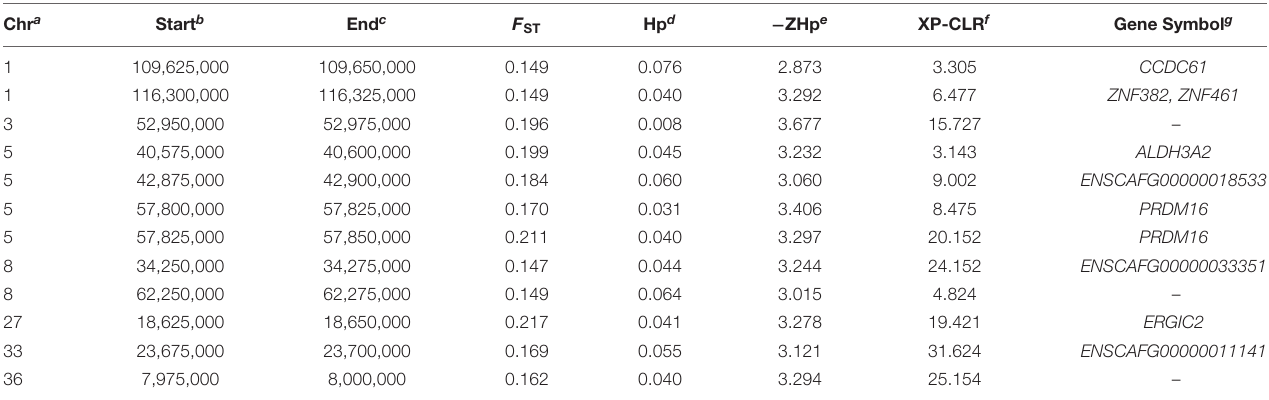
a Chromosome. b Start position of the region. c End position of the region. d H p value of Mame Shiba